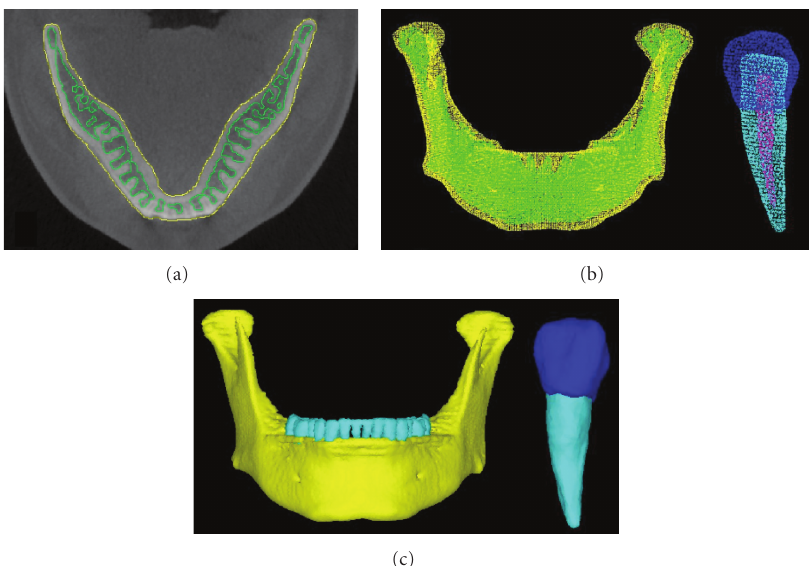
Figure 3: Geometry of 3D images and 3D models. (a) ROI of CT image, (b) 3D solid model, (c) 3D FE models.